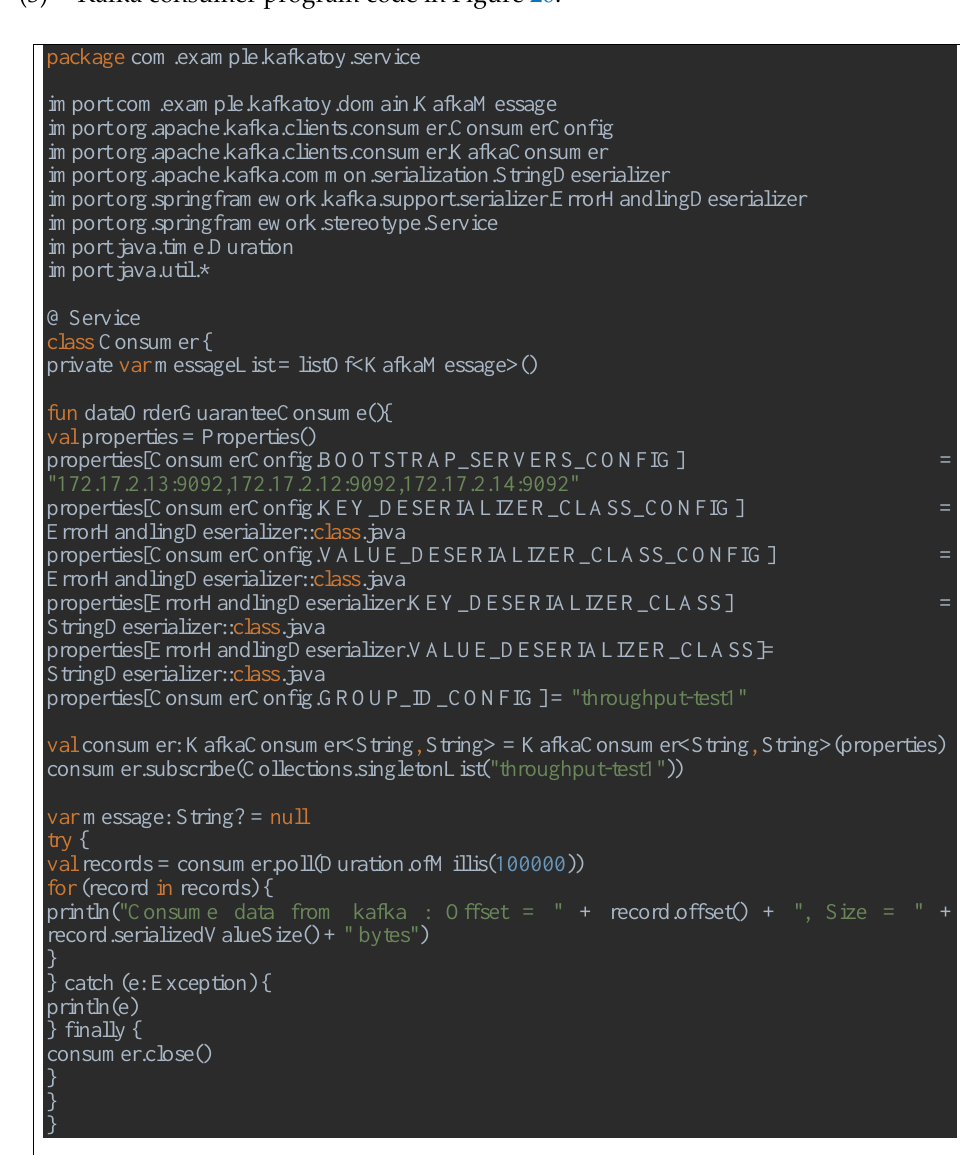
Figure 20. Source code of performance evaluation for producer.